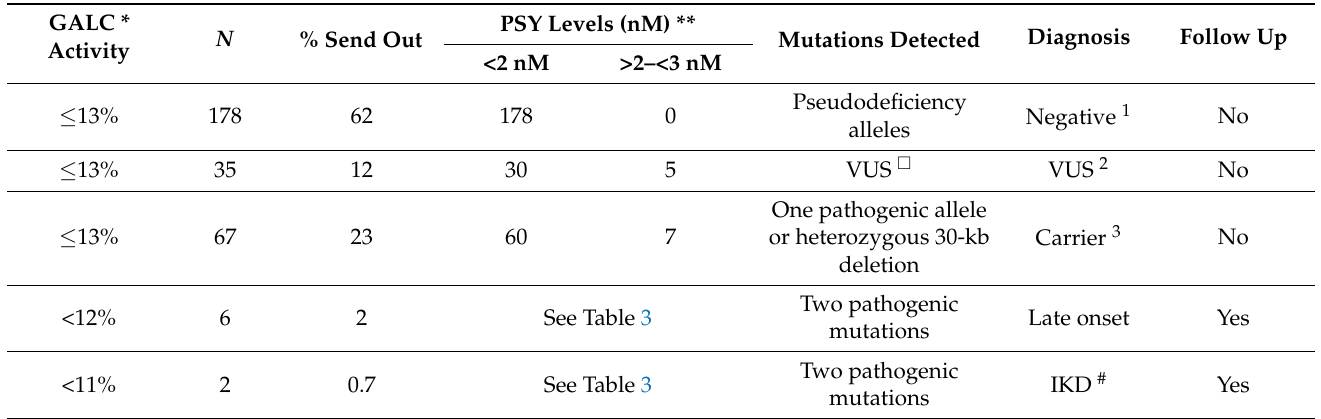
Table 2. Assignment of diagnosis after receiving second-tier testing results for KD (n =